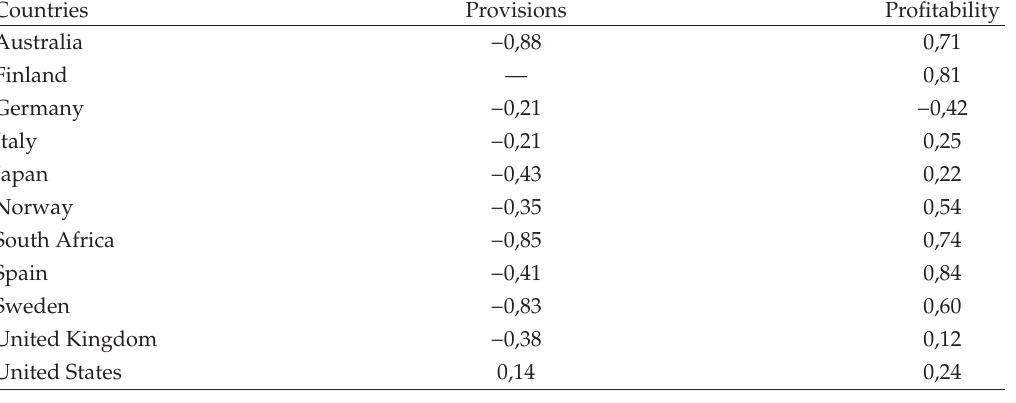
Table 2: Correlations between provisions and profitability.